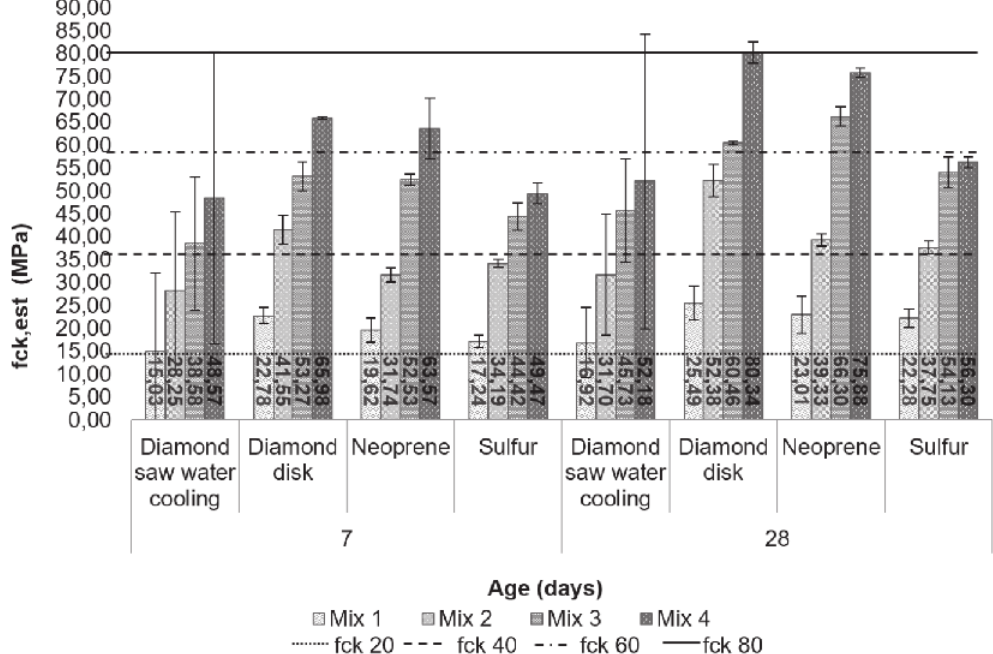
Figure 6 Correlation between estimated strength of mixes 1, 2, 3 e 4 and the different surface preparation systems and fck